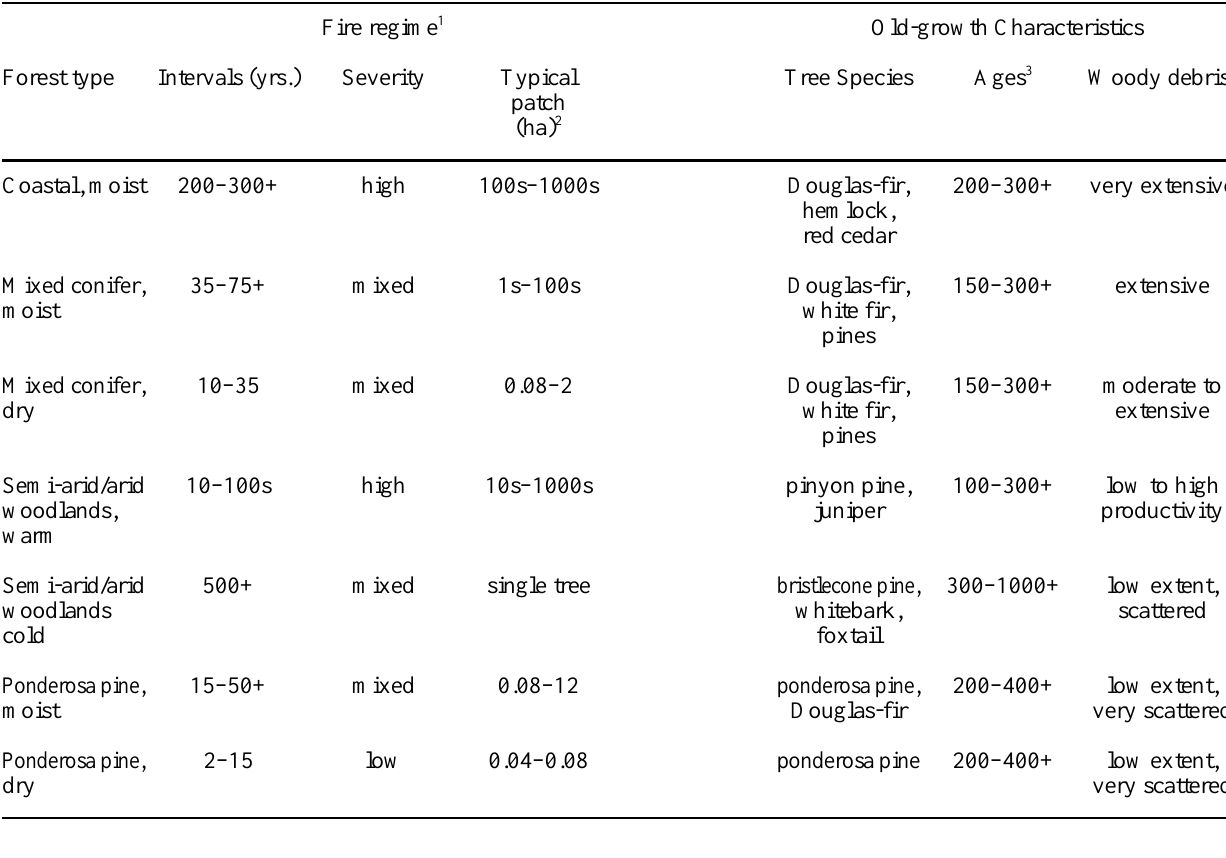
Table 2. Features of typical old-growth forest types. (A) Generic features for moist and dry forest types; (B) features found in specific geographic regions reported in the section on case